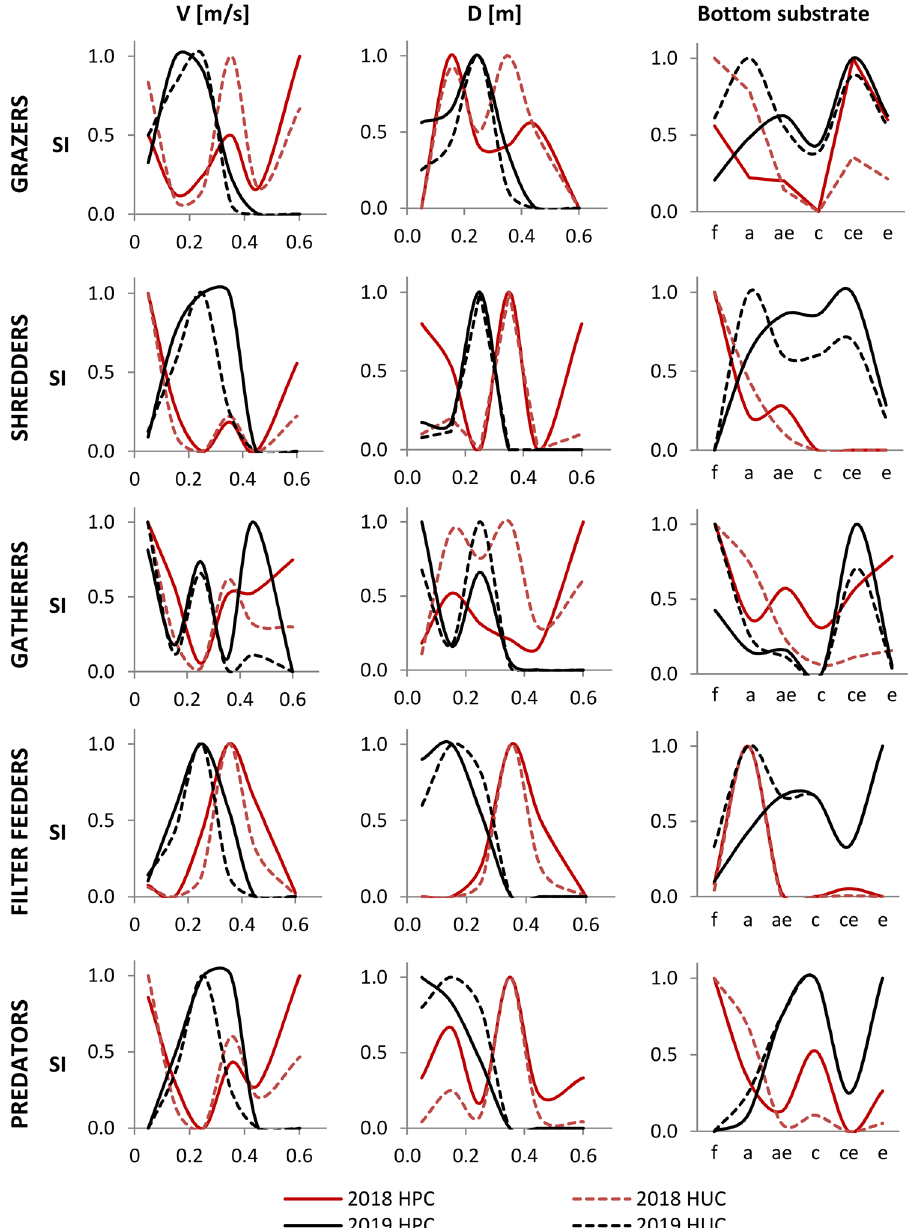
Figure 6. Habitat preference curves (HPCs) and habitat utilization curves (HUCs) for FFGs separately for 2018 and 2019 samples. Categories of substrate: a—fine sand, c—medium sand, ae—fine sand with gravel, ce— medium sand with gravel, e—gravel,